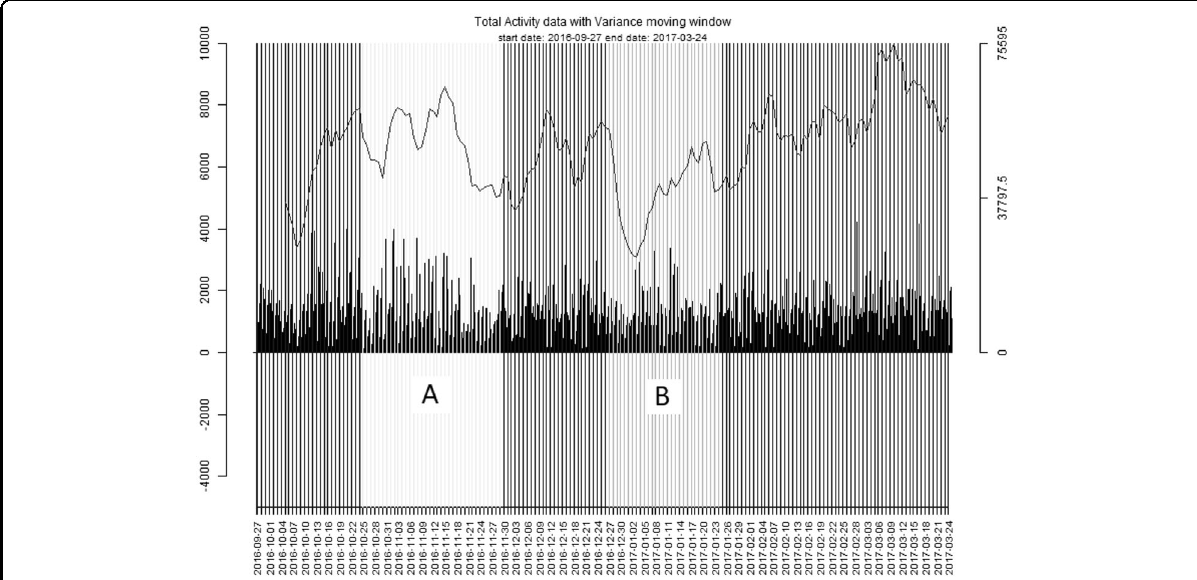
Fig. 1 Variance marker of patient 1, calculated from a moving window of the activity data (see method section for details). The left set of light-gray vertical lines indicated with an “ A ” represent the euthymic period. The right set of light-gray vertical lines indicates with a “ B ” represent the episode period. The y-axis shows the variance of the activity while the x-axis represents time in